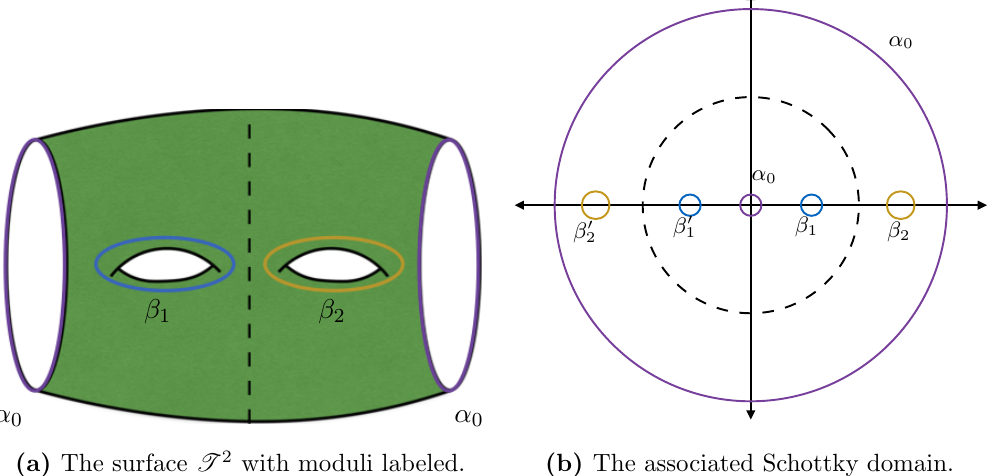
Figure 21 . The Z 2 symmetric surface and Schottky domain used to compute the moduli of T 2 . Note that j (cid:12) 1 j = j (cid:12) 2 j by the re(cid:13)ection symmetry across the dashed cycle.